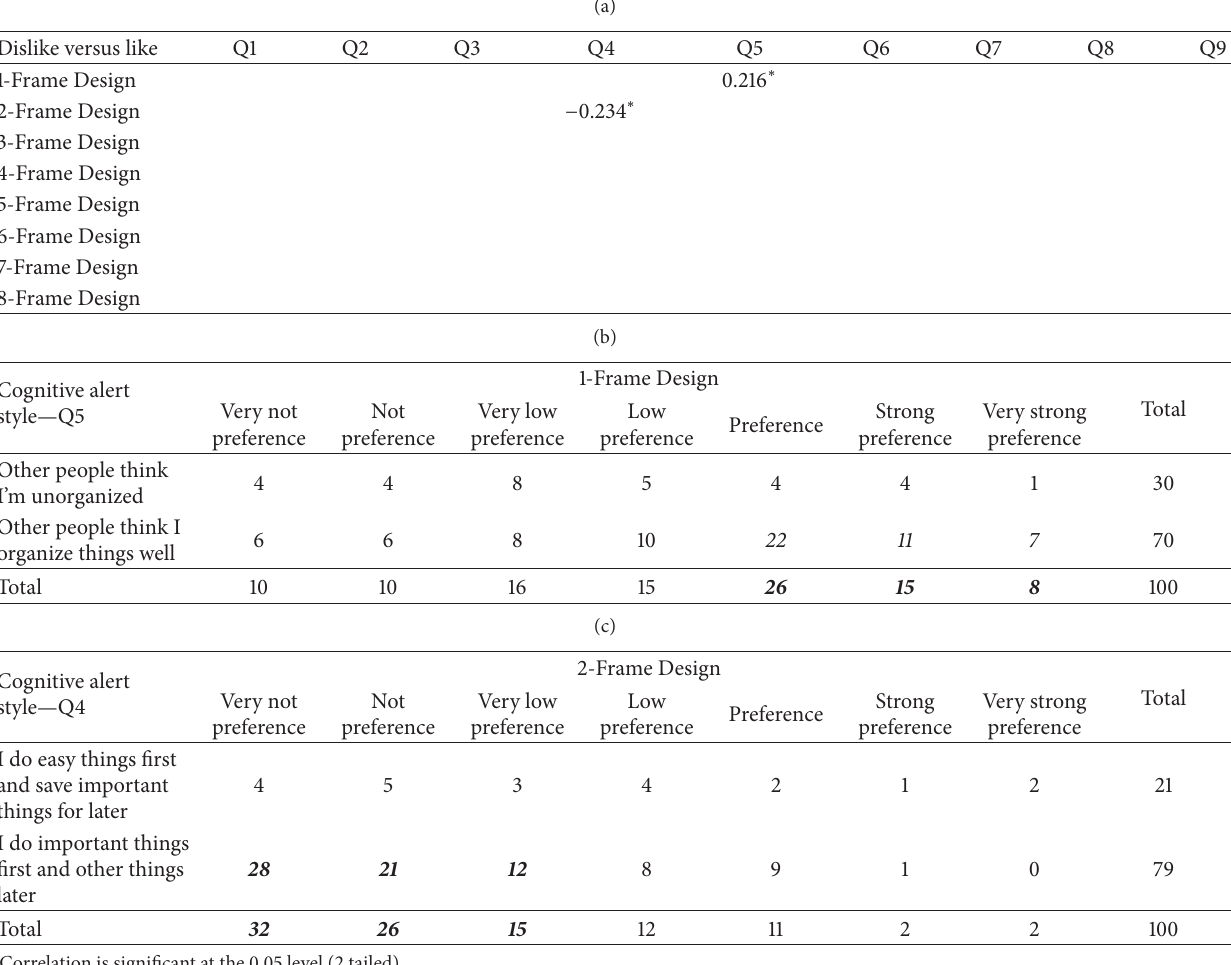
Table 23: Correlation between cognitive alert style and the preferences of the 8 designs proposed.